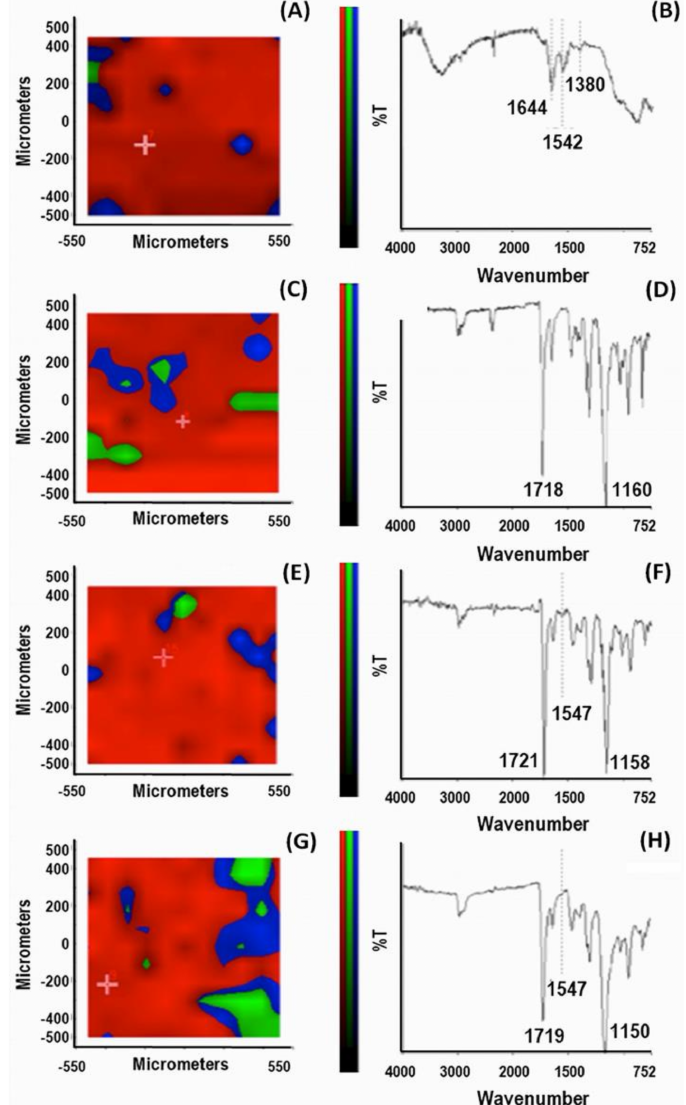
Figure 5. FT-IR Chemical Imaging analysis. PCA map and corresponding spectrum: ( A , B ) pure MMP9 after casting the enzyme aqueous solution; ( C , D ) CPs; ( E , F ) MIPs before MMP9 extraction; ( G , H ) MIPs after MMP9